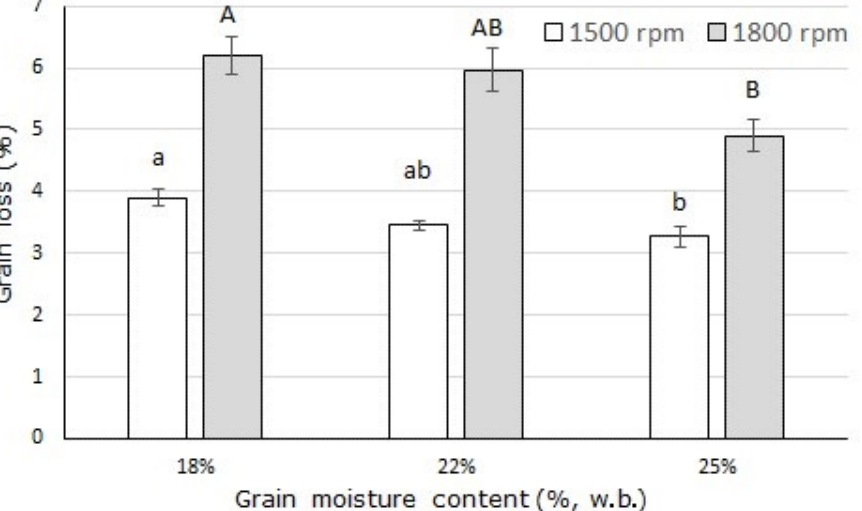
Figure 8. Effect of grain moisture content on grain loss. Error bars represent ± standard deviation, n = 3. Means followed by the same letter and font are not significantly different at p < 0.05 according to Duncan’s Multiple Range Test.